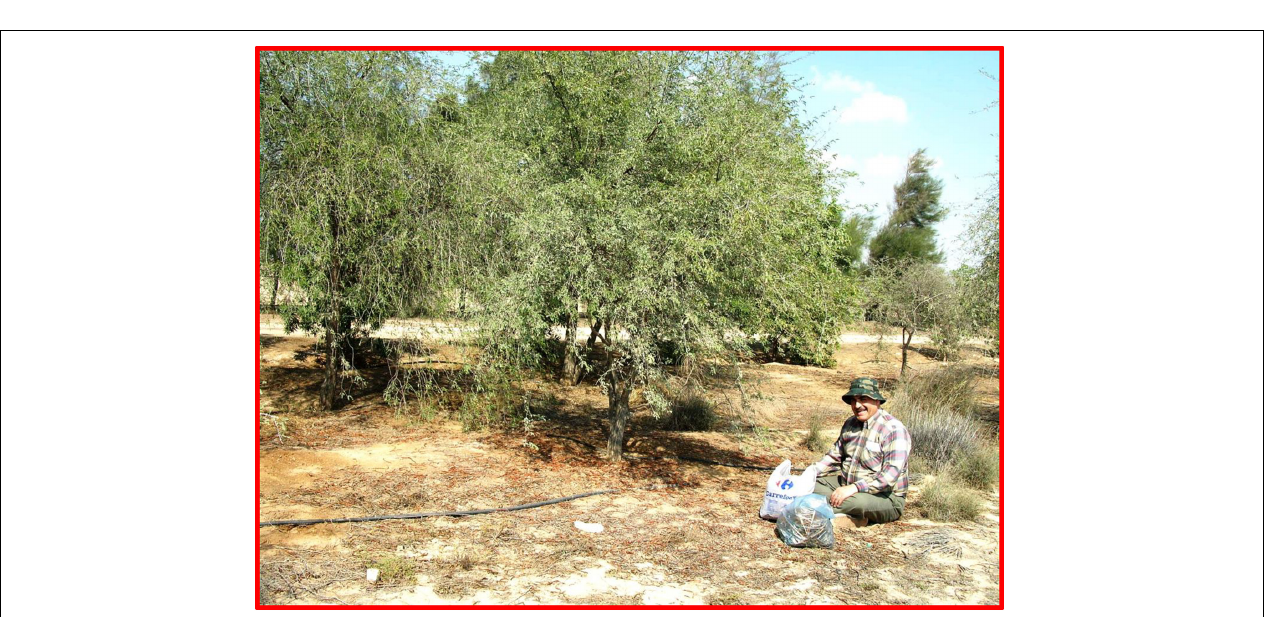
FIGURE 6 | The soil of the Rawdahs is rich in biological soil crusts (BSC), which have various biological roles.